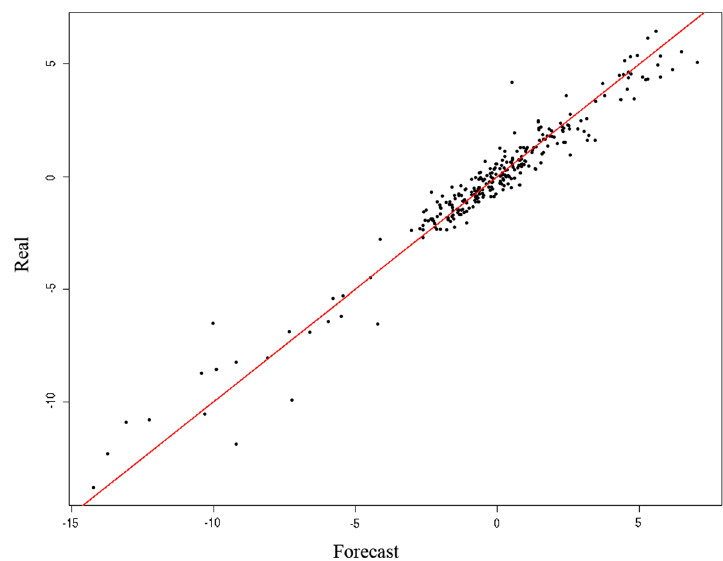
Fig. 7 Goodness of fit of the model designed, described by the covariant of the series cumulative number of COVID‑19 cases. Source : Authors’